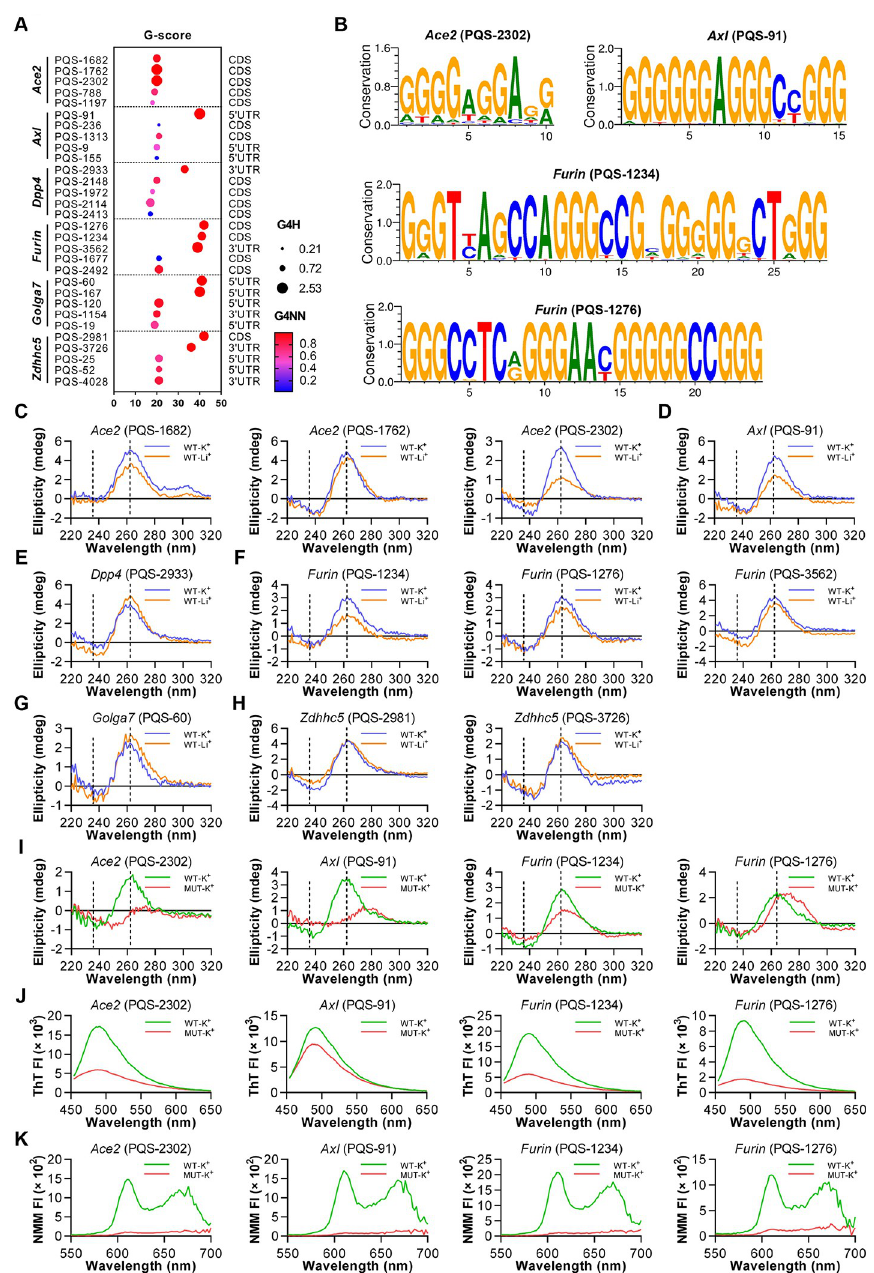
Fig 1. Characterization of RG4s in SARS-CoV-2 host factors. (A) RG4 potential of SARS-CoV-2 host factor mRNAs. Prediction results are shown with multi-parameter analysis of G-sore, G4H and G4NN. (B) Graphical representations of RG4 sequence conservation of PQSs in Ace2 , Axl and Furin . The sequences were retrieved from the National Center for Biotechnology Information (NCBI) and aligned using WebLogo software. (C-H) CD spectrum for indicated PQSs of Ace2 (C), Axl (D), Dpp4 (E), Furin (F), Golga7 (G), and Zdhhc5 (H) under KCl or LiCl conditions. (I-K) CD spectrum (I), ThT (J) and NMM (K) fluorescence emission spectra for wild-type (WT) or mutated (MUT) of Ace2 PQS-2302 (first panel), Axl PQS-91 (second panel), and Furin PQS-1234 (third panel) and PQS-1276 (fourth panel) under KCl conditions.